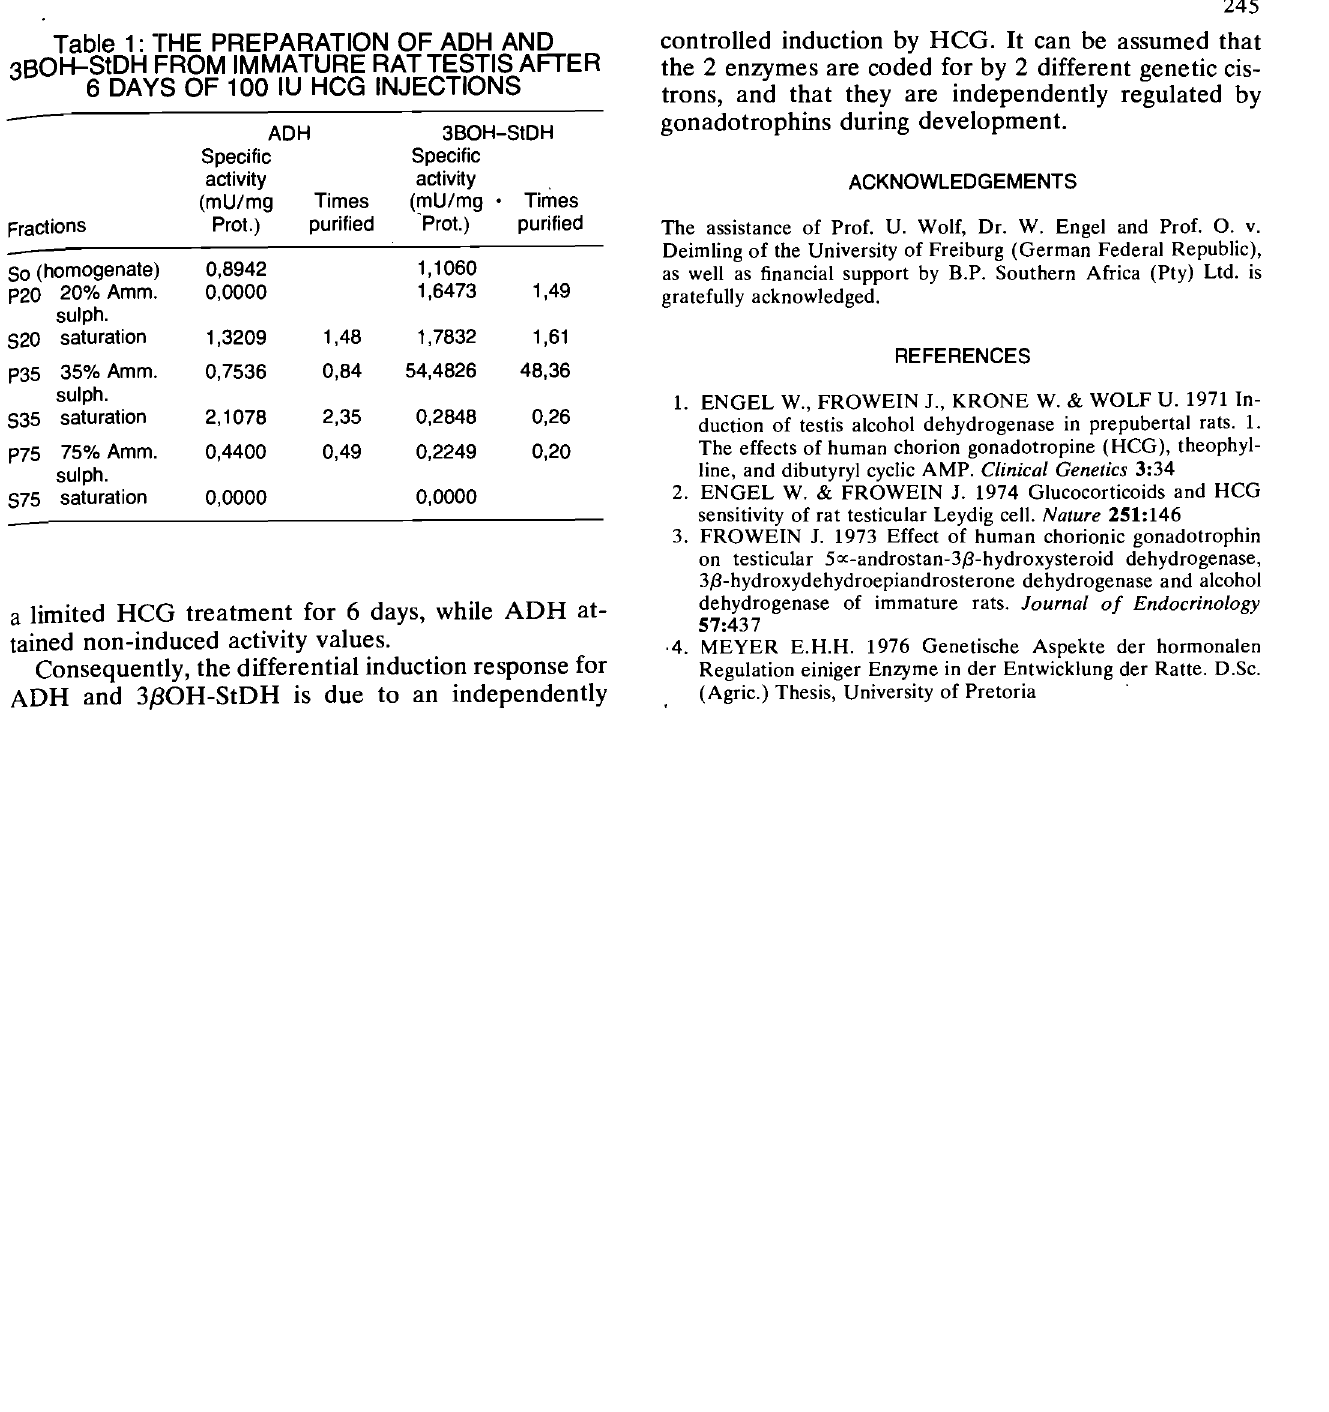
Table 1: THE PREPARATION OF ADH AND 3BOH-StDH FROM IMMATURE RAT TESTIS AFTER 6 DAYS OF 100 IU HCG